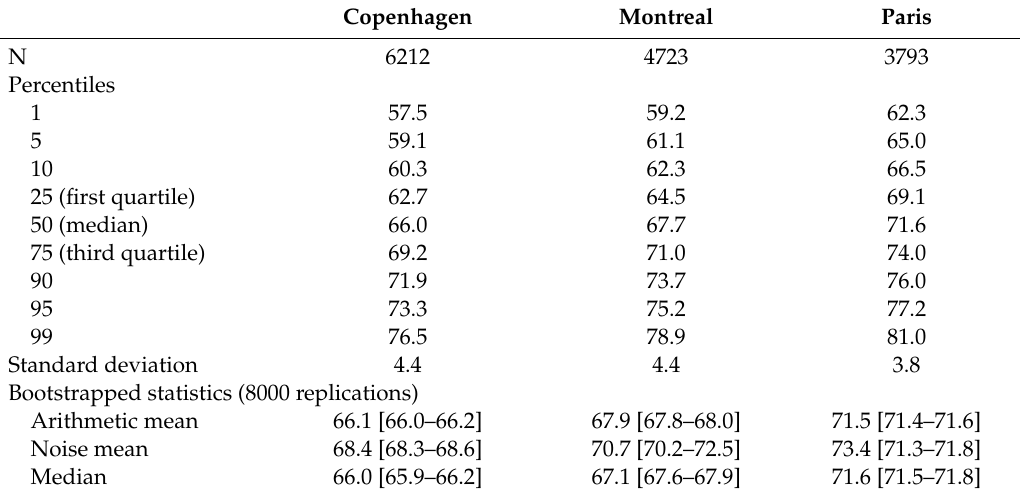
Table 1. Distribution of 1 min averages of noise levels (in dB(A)) during cycling routes per city. Copenhagen Montreal Paris